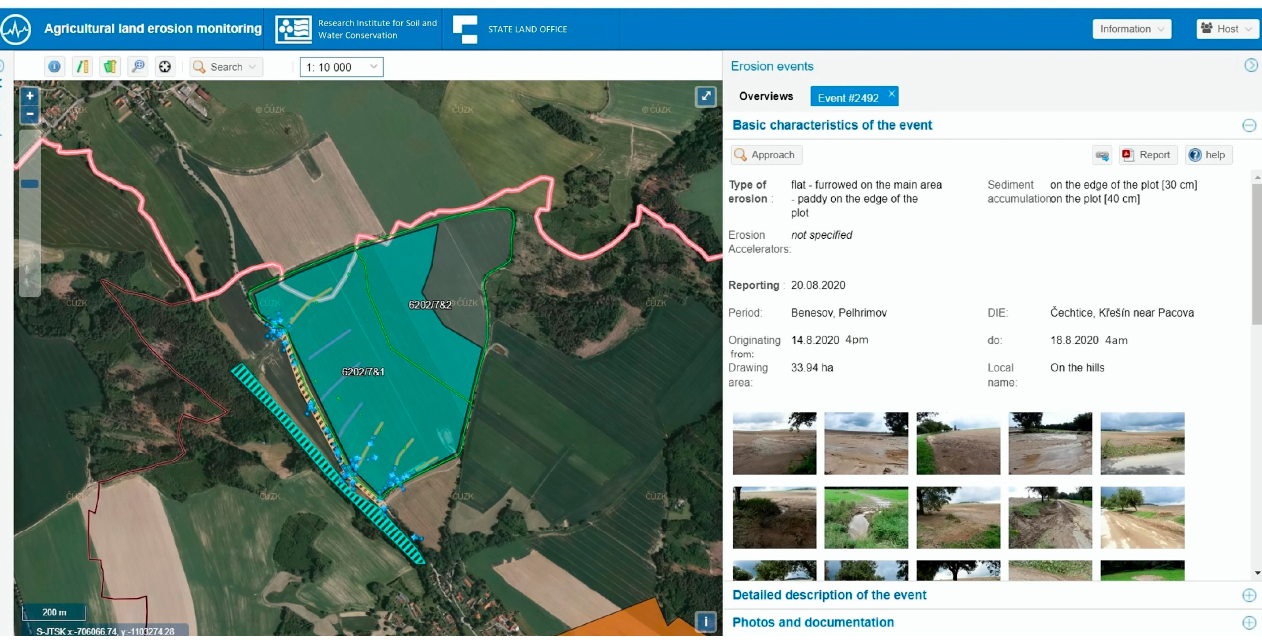
Figure 2. An example of the relation of EEA and a reported and recorded erosion event.